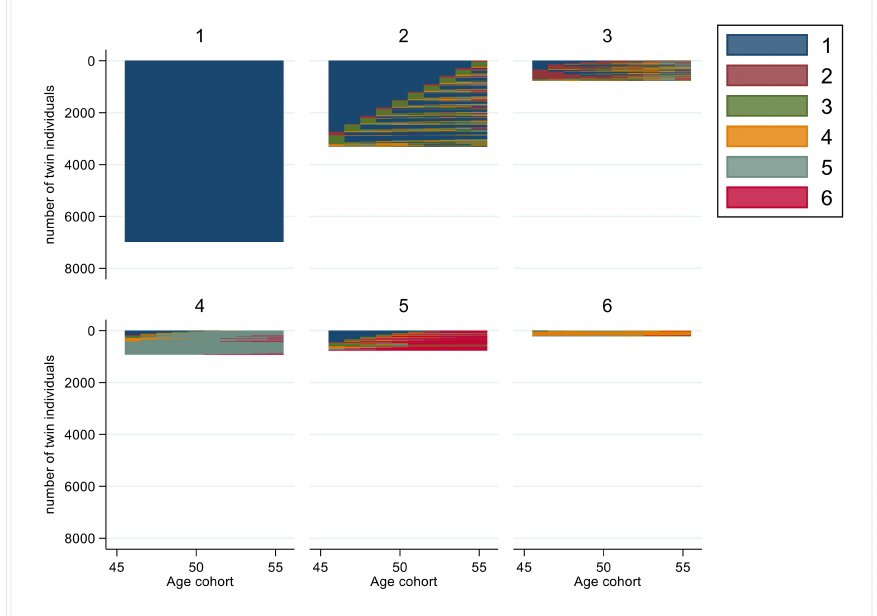
Figure 3. Cluster groups of sequences of interruptions in working life among the age cohort 46–55 years. (Code for colors: 1. sustainable working life : SA/DP 0–30 days and UE 0–90 days; 2. Unemployment > 90 days : SA/DP 0–30 days and UE > 90 days; 3. Moderate SA/DP : SA/DP 30–180 days; 4. Almost full year of SA/DP :